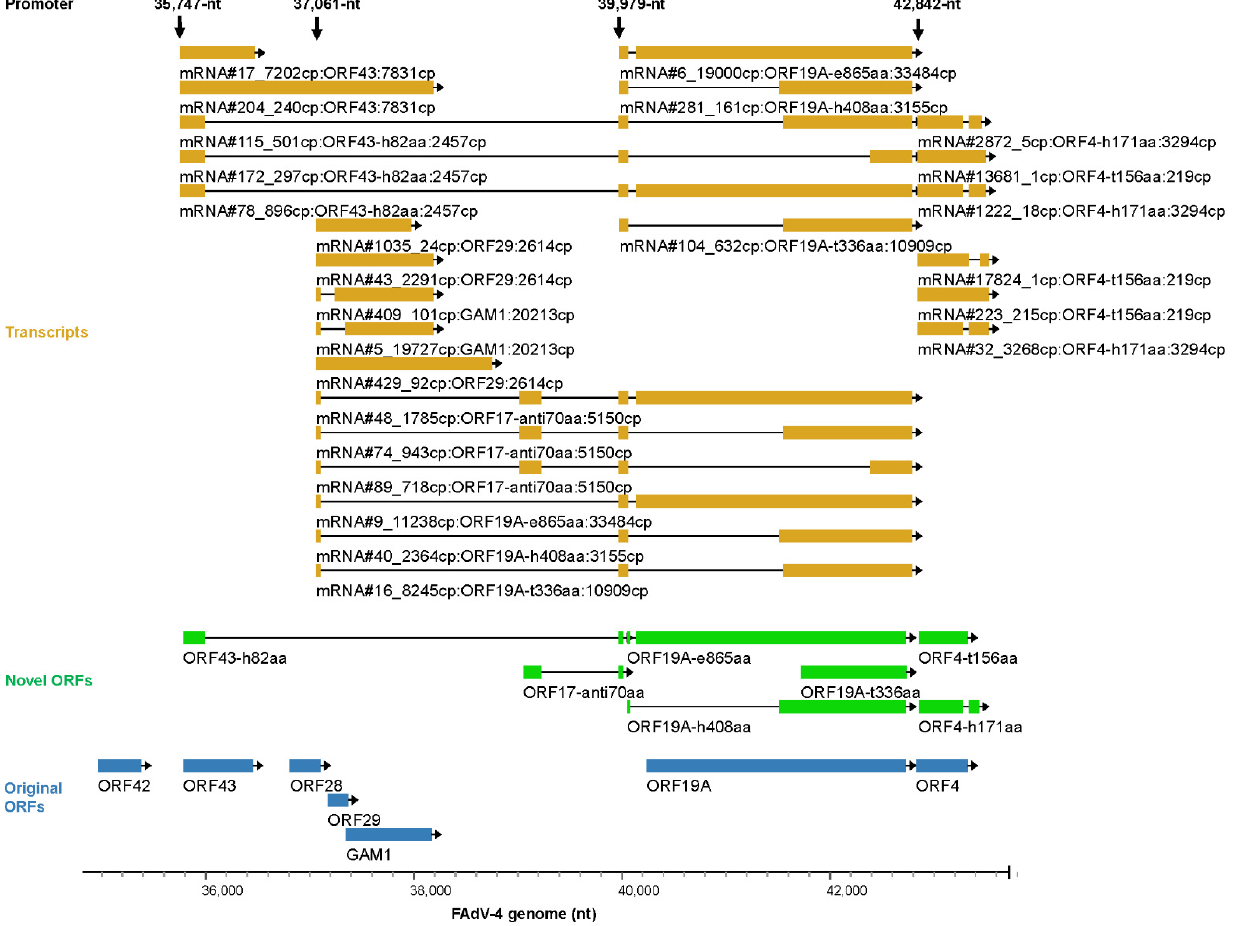
Figure 7. Key transcripts controlled by the forward 35,747-nt, 37,061-nt, 39,979-nt and 42,842-nt promoters. The related annotation and explanation can be found in the legend of Figure 5.